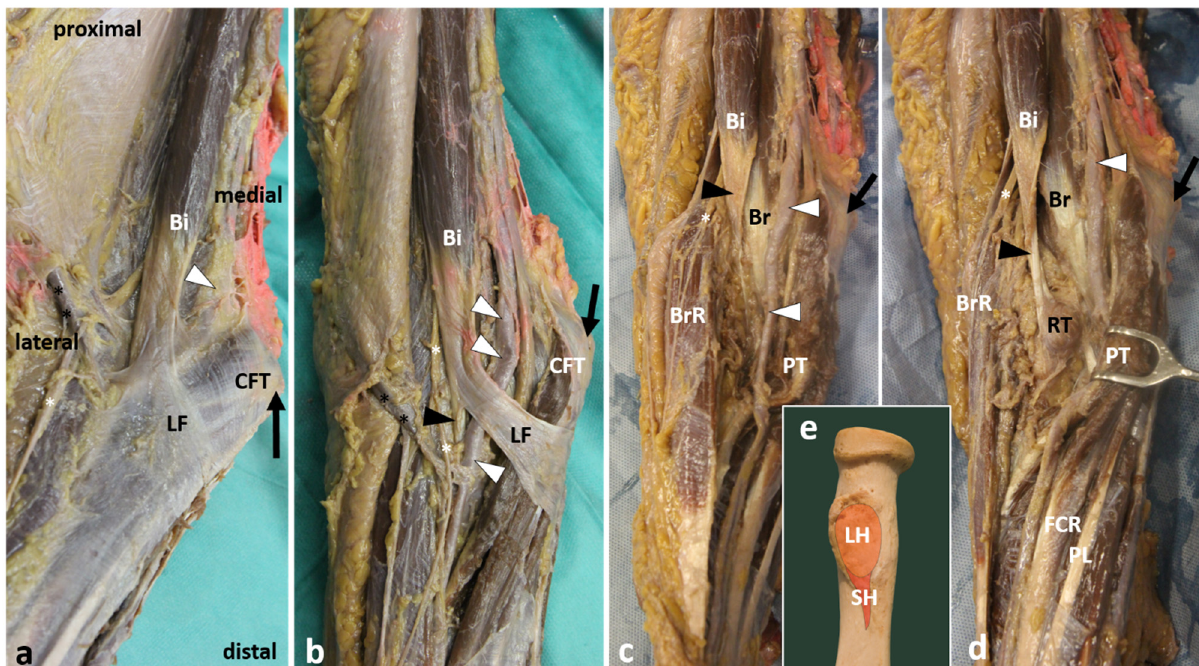
Figure 8. Insertion of biceps brachii. The cadaveric specimen shows an anteromedial aspect of the right elbow joint (all specimens were in the same position). ( a , b ) Lacertus fibrosus (bicipital aponeurosis) fans out in the forearm’s fascia and covers the brachial artery. ( c , d ) The proper tendon of the biceps continues to the radial tuberosity. Its position is changing during pronation ( c ) and supination ( d ). Notably, during the supination, the bicipital tendon is moving anteriorly and superficially. ( e ) Area of insertion of the biceps tendon on radial tuberosity—proximally is situated tendon springs off from the long head (LH) and more distally inserting tendon from the short head (SH). Black arrow: medial epicondyle, black arrowhead: bicipital tendon, white asterisk: lateral cutaneous nerve of forearm, black asterisk: median cubital vein, white arrowhead: brachial artery, Bi: biceps brachii muscle, Br: brachialis muscle, BrR: brachioradialis muscle, CFT: common flexor tendon, LF: lacertus fibrosus (aponeurosis of the biceps brachii), PT: pronator teres muscle, RT: radial tuberosity.